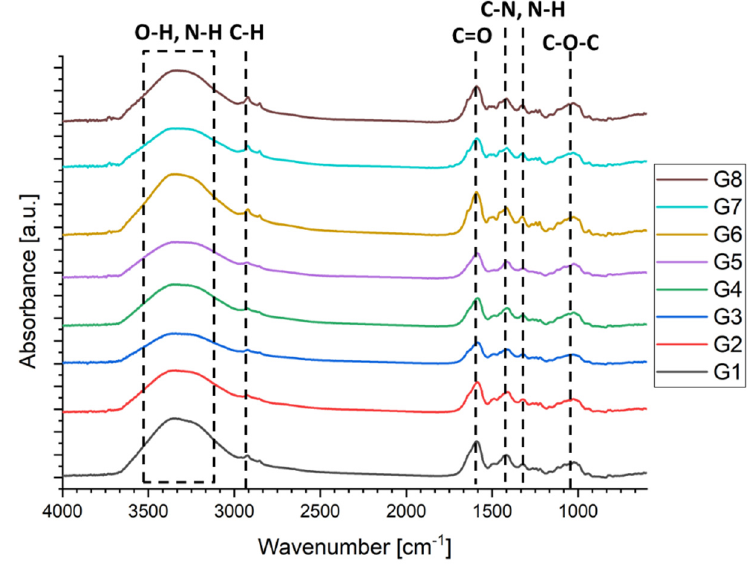
Figure 1. FT-IR spectra of the obtained microcapsules.